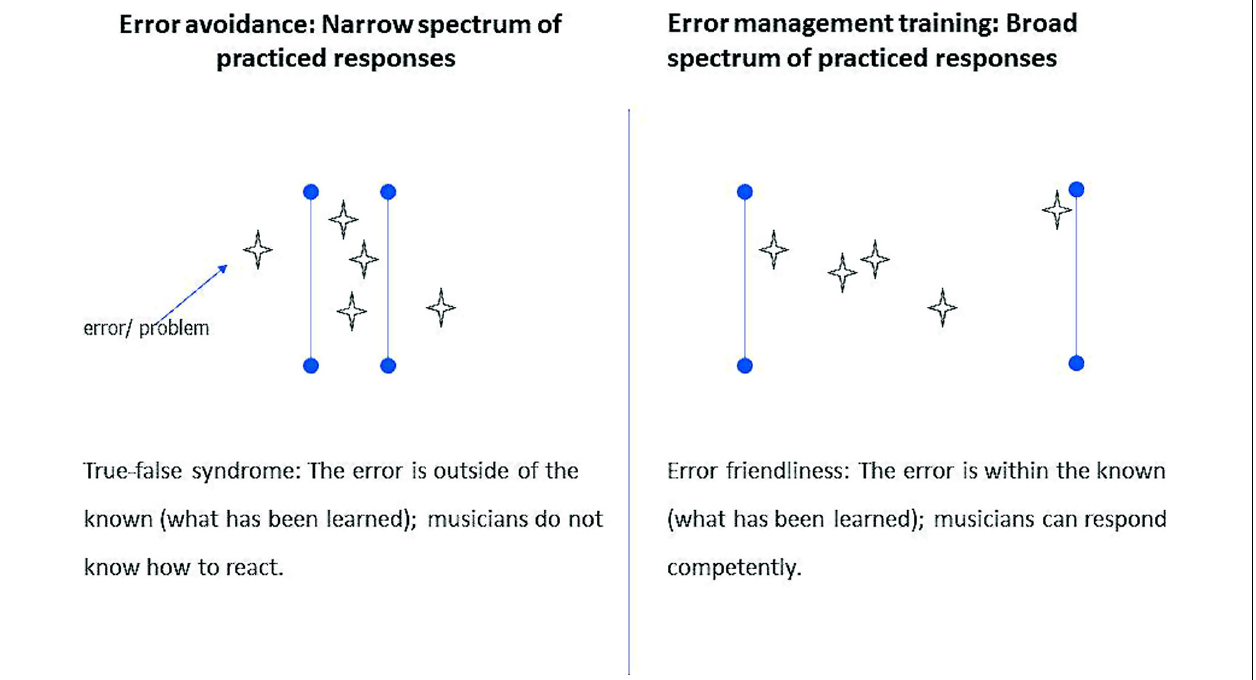
FIGURE 1 | Extension of the range of solutions (Kruse-Weber, 2012a) .